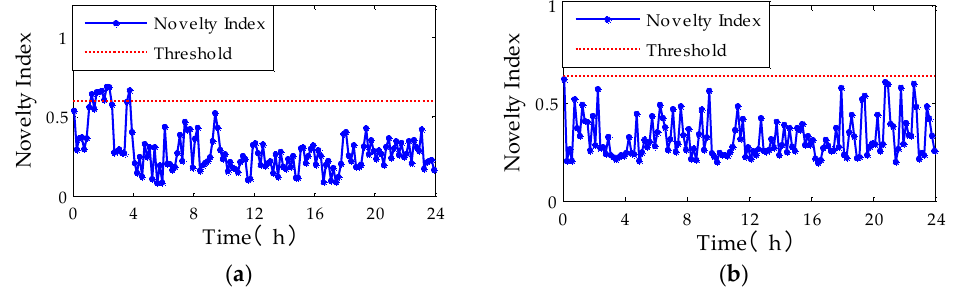
Figure 20. Novelty index obtained using artificial-neural-network (ANN)-based novelty detection: ( a ) Quarter span; ( b ) half span.